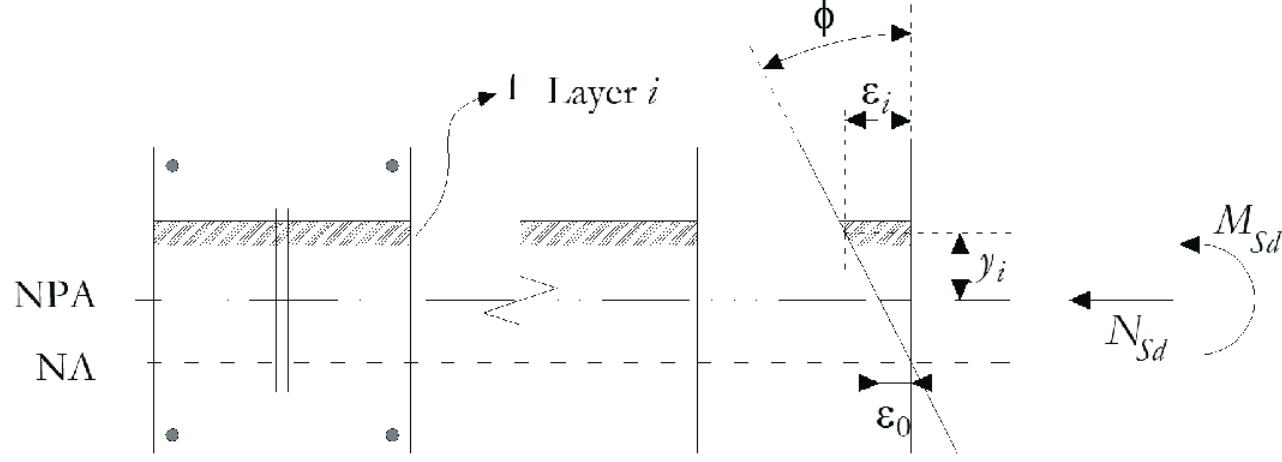
2D linear strain